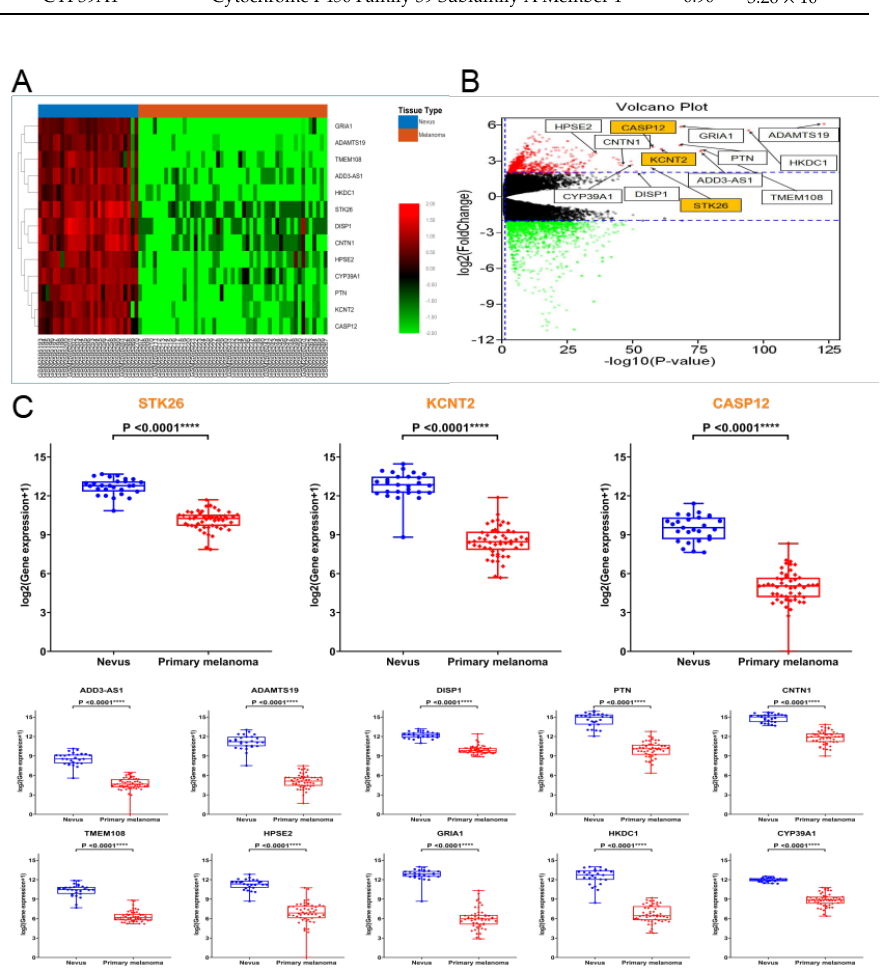
Figure 4. Candidate hub genes. ( A ) The heatmap of 13 candidate hub genes. The 13 genes were all upregulated in nevus compared to melanoma. ( B ) The volcano plot of 1276 differentially expressed genes. The 13 candidate hub genes are highlighted, and all were differentially expressed genes. ( C ) Gene expression levels of the 13 candidate hub genes between nevus and primary melanoma based on the GSE98394 datasets . Student’s t test was used to evaluate the statistical significance of differences. After screening by the edgeR package, 1276 di ff erentially expressed genes were obtained (Figure 4B), and the 13 candidate genes were found to be di ff erentially expressed genes. The